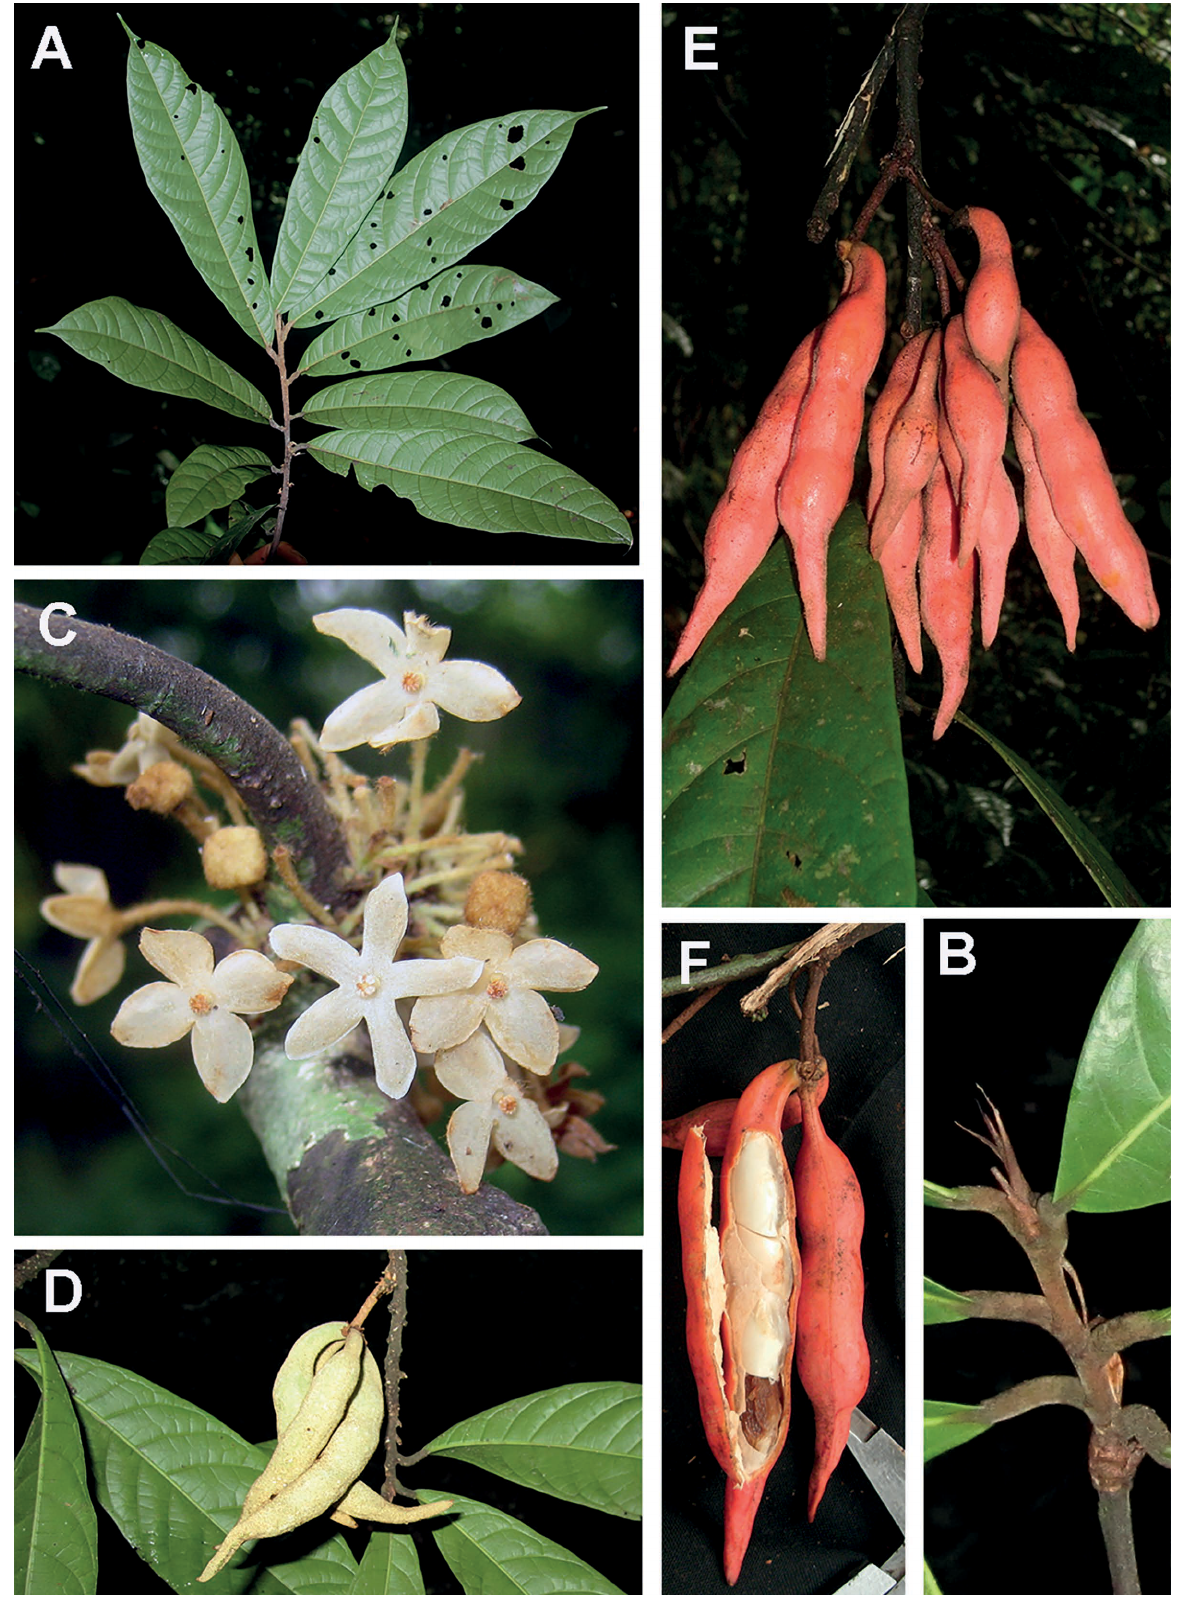
Figure 2 – Cola zemagoana : A, leafy twig from below; B, stipules; C, fascicles; D, immature fruit; E, mature fruits (from more than one flower); F, opened fruitlet showing seeds. Photographs: A, B & D by D. Kenfack; C, E & F by M.